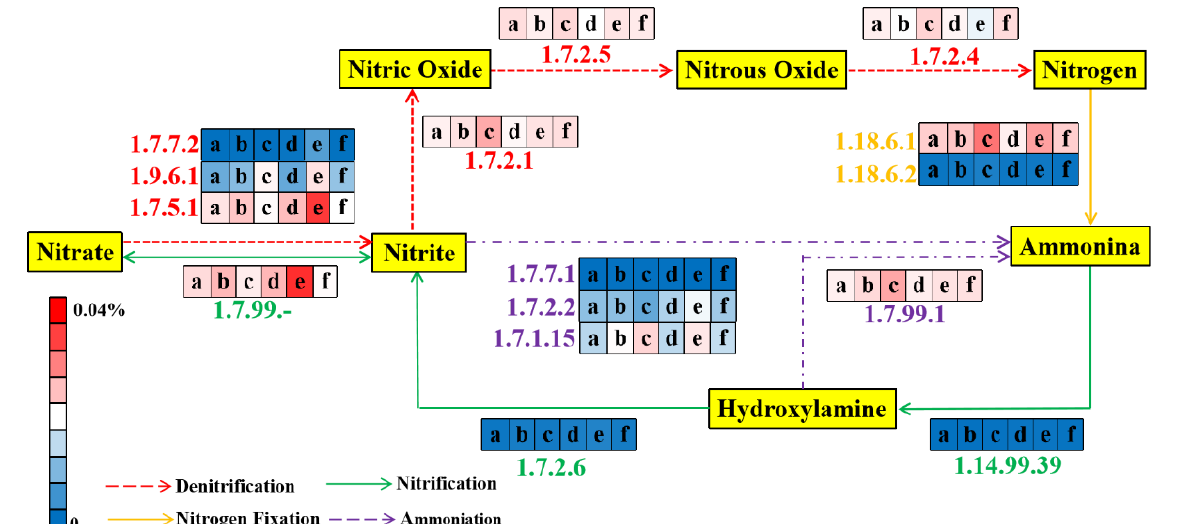
Figure 6. Nitrogen pathway and average relative abundances of enzyme-encoding genes in AOA S150 and AOA S300 bioreactors (a, c, and e represent the initial, middle, and final stage of AOA S150 ; b, d, and f represent the initial, middle, and final stage of AOA S300 , respectively).